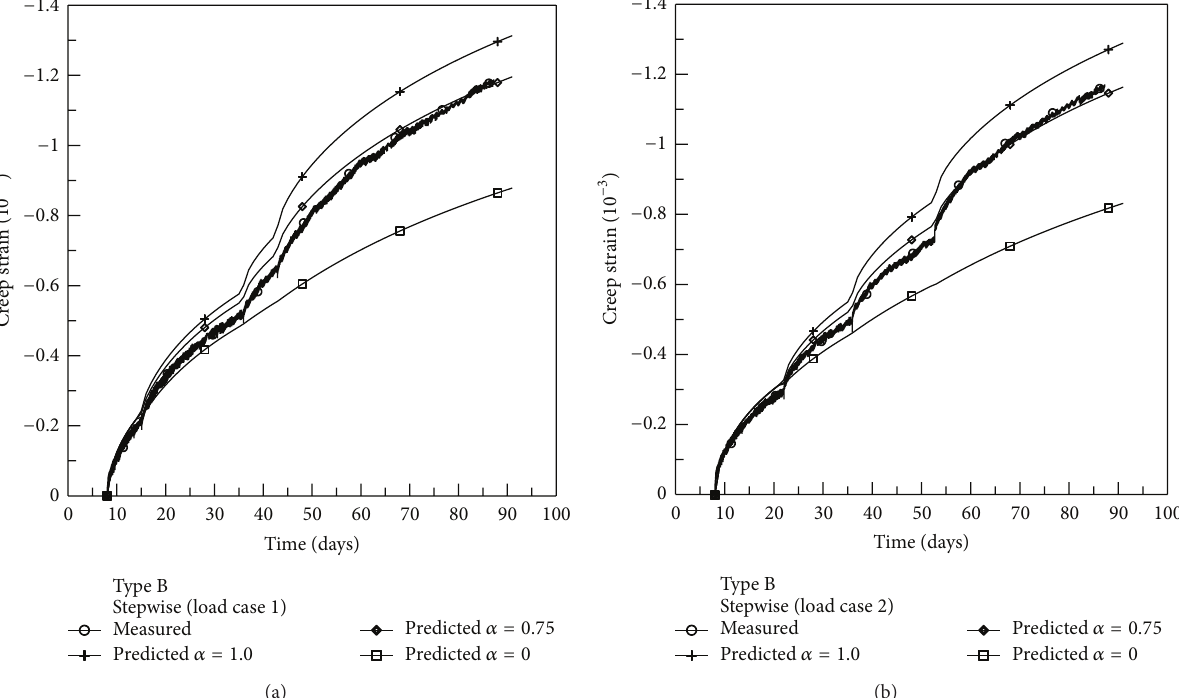
Figure 9: Predicted and measured creep strains for the two stepwise load cases of type B test: (a) load case 1 and (b) load case